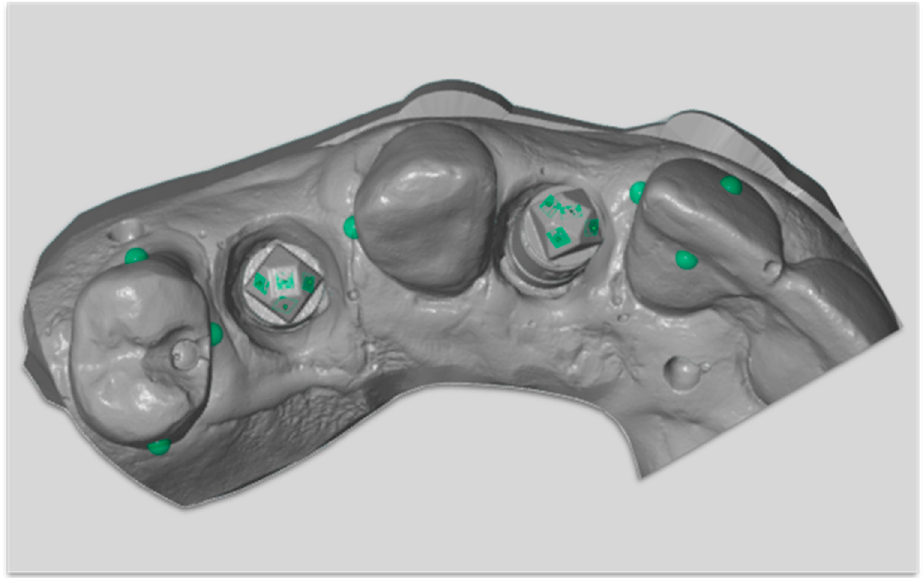
Figure 3. Surface topography measurement on different tooth surfaces.